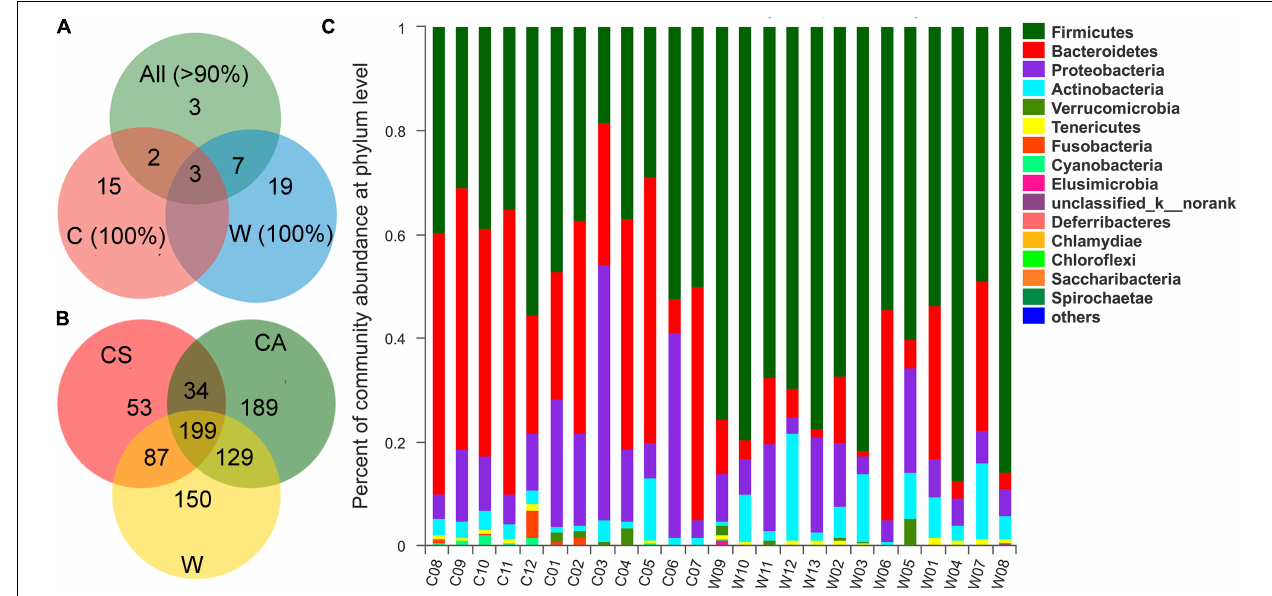
FIGURE 1 | (A) Veen diagrams show the number of shared and unique core Operational taxonomic units (OTUs) among the core OTUs of all samples ( > 90%), the core OTUs of wild samples (100%), and the core OTUs of captive samples (100%). (B) Veen diagrams show the number of shared and unique OTUs among CS, CA, and W groups. (C) Community bar plot analysis of bacterial at the phylum